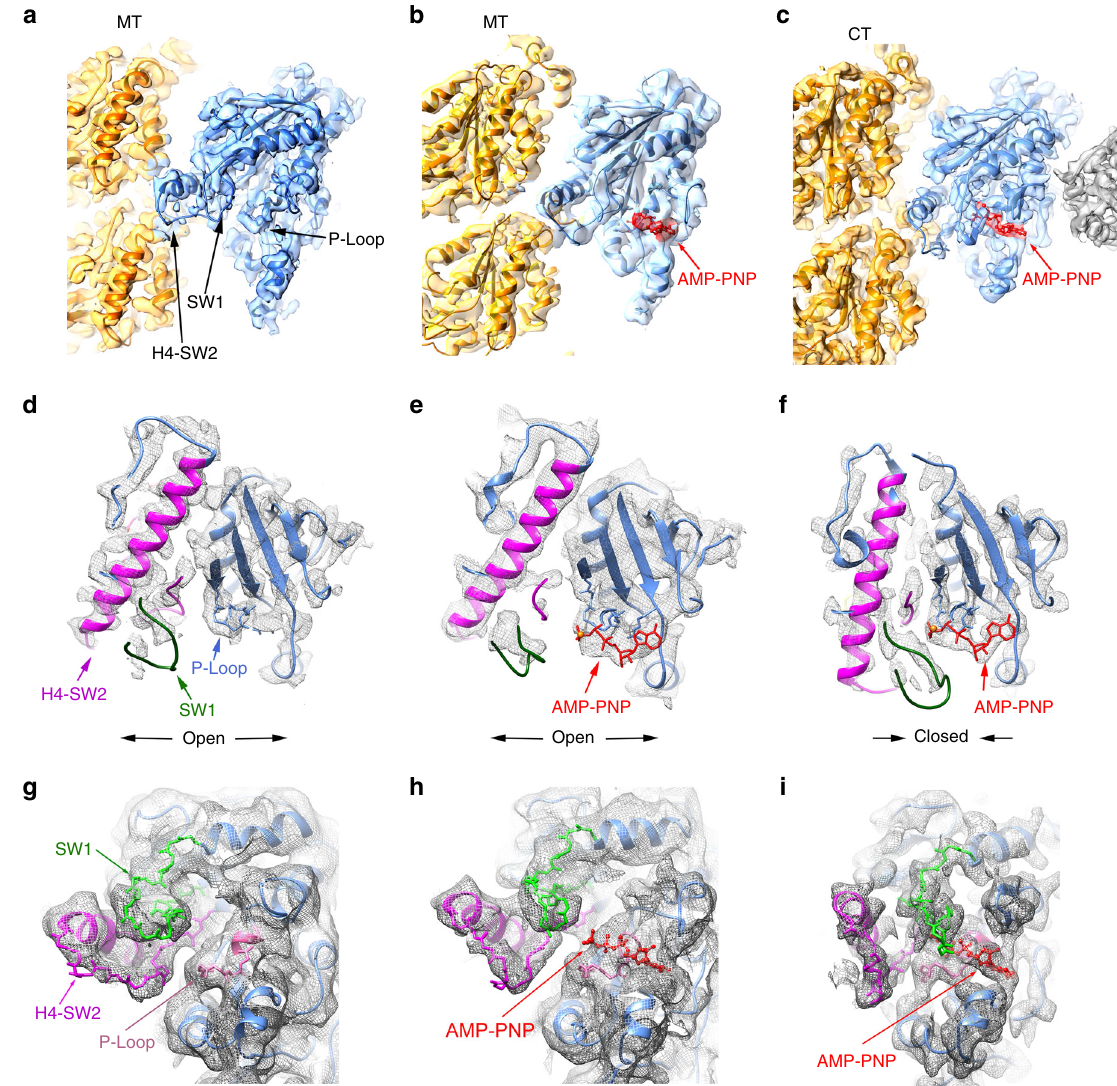
Fig. 2 KLP10A nucleotide binding pocket. a – c Side views (tubulin plus-end up). d – f Top view detail of the KLP10A nucleotide binding pocket. g – i Side view detail of the KLP10A nucleotide binding pocket. a, d, g NMMT apo . b, e, h NMMT AMP-PNP . c, f, i CTMMT AMP-PNP . In a , b : KLP10A blue; tubulin yellow; cryo- EM density as a gray semi-transparent surface. In c – i : KLP10A blue, H4-SW2 magenta, SW1 green, P-loop pink, AMP-PNP red, cryo-EM density as a gray mesh